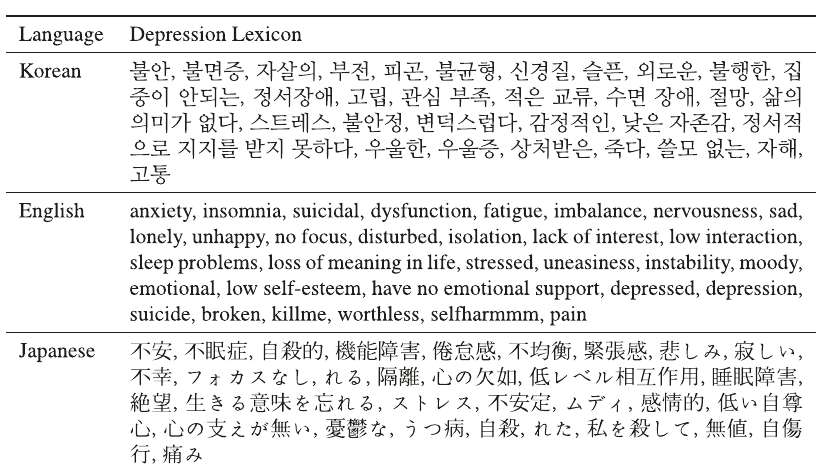
Table 1 Depression lexicon for Korean, English, and Japanese.